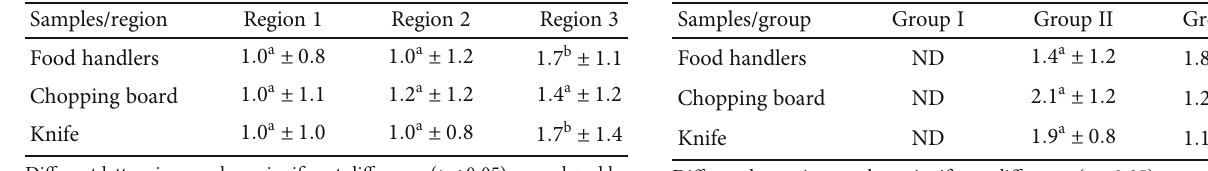
Table 4: Hygiene practices and cross contamination in restaurants among regions based on Enterobacteriaceae (log cfu/cm 2 ).